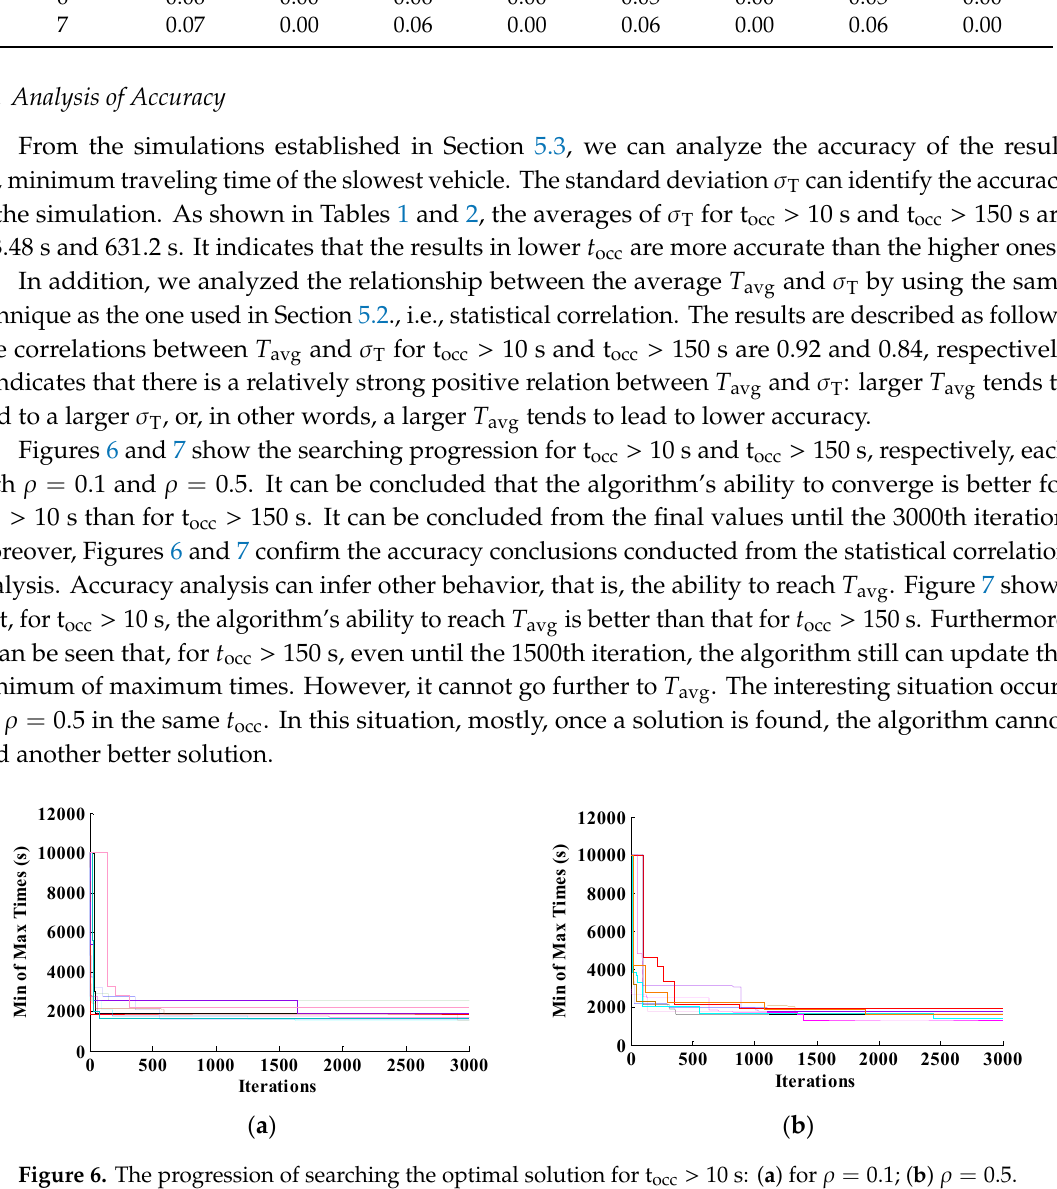
( b ) Figure 7. The progression of searching the optimal solution for (cid:1872) (cid:2925)(cid:2913)(cid:2913) > 150 s: ( a ) for (cid:2025) = 0.1 ; ( b ) (cid:2025) = 0.5 .